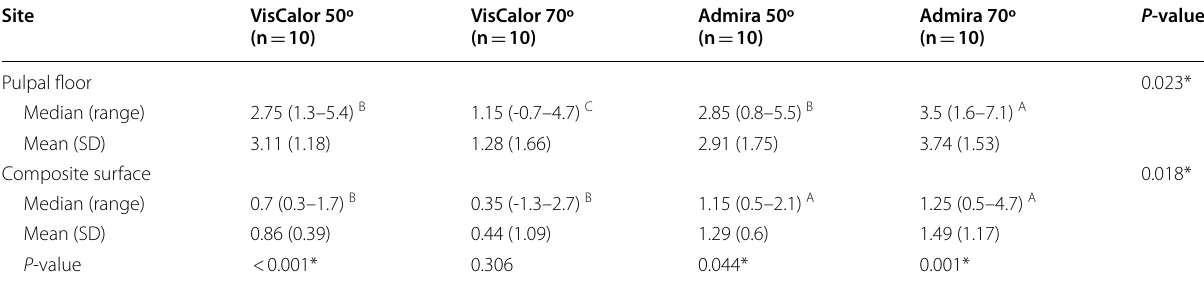
* Significant at P 0.05, Different superscripts in the same row indicate statistically significant difference ≤